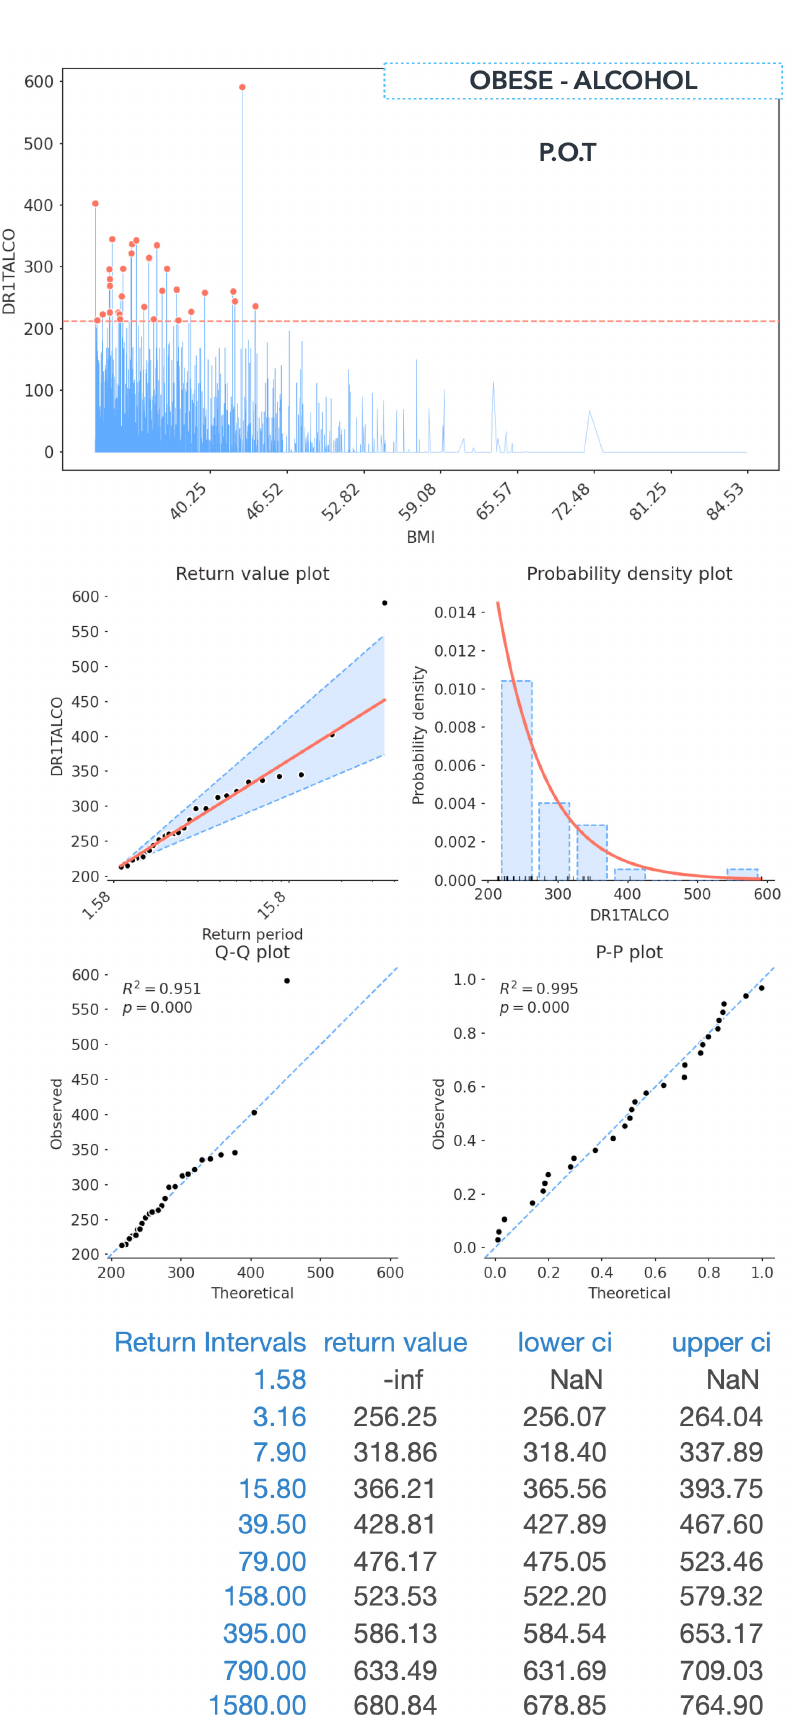
Figure 11. Obese category–EVA of alcohol